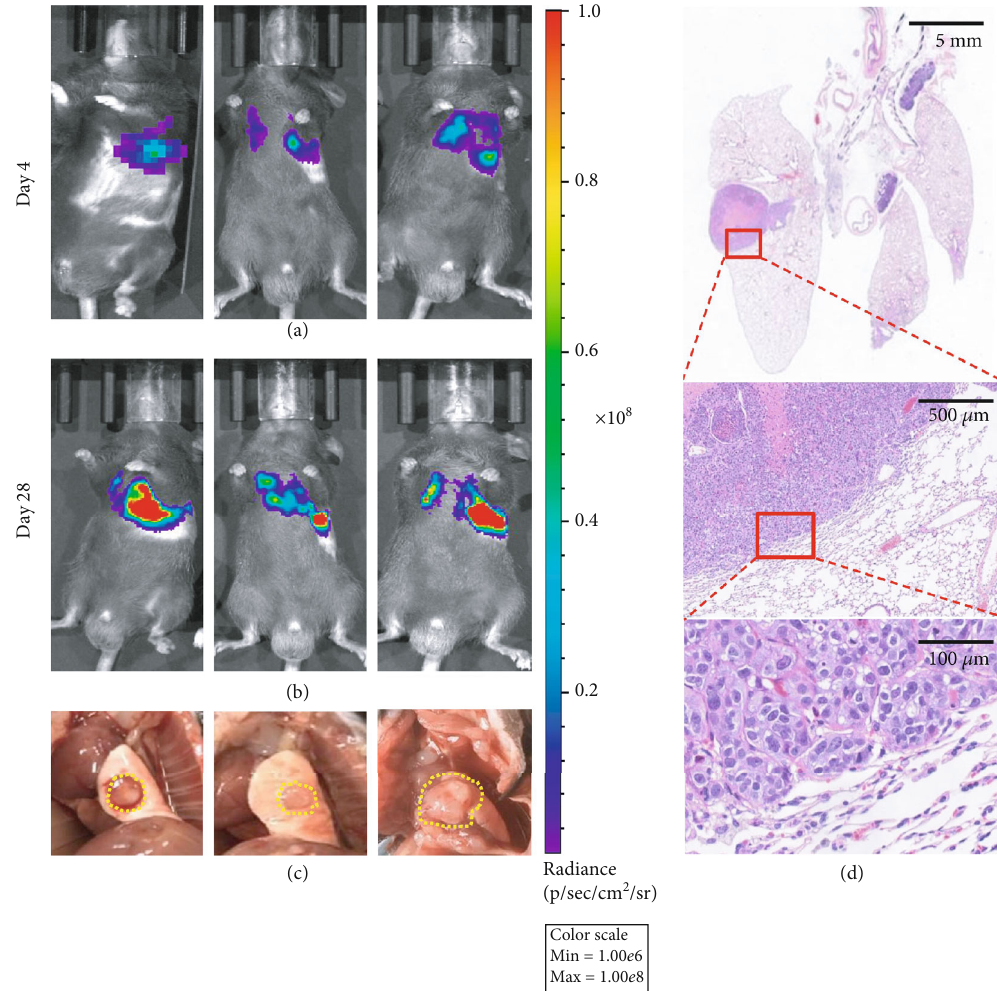
Figure 1: Establishment of the orthotopic lung cancer mouse model. The LLC-Luc cells ( 1 : 2 × 10 5 cells/mouse) were orthotopic inoculated in the left lung of C57BL/6 mice. (a, b) The mice bioluminescence images on the 4th day and the 28th day after the tumor cell injection. (c) Harvested lung tissues. (d) H&E staining of lung